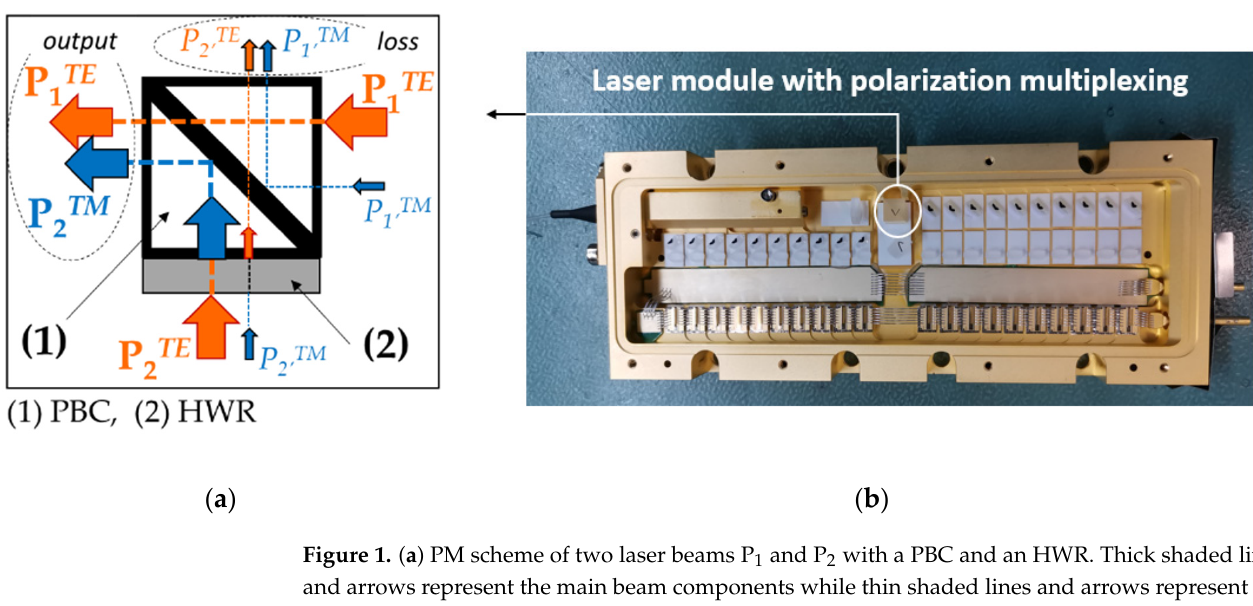
Figure 1. ( a ) PM scheme of two laser beams P 1 and P 2 with a PBC and an HWR. Thick shaded lines and arrows represent the main beam components while thin shaded lines and arrows represent the minor components. TE polarization is shown in orange while TM polarization is shown in blue. ( b ) 350 W multi-emitter module is based on PM of two laser beams obtained by two sets of the HPLD investigated here.